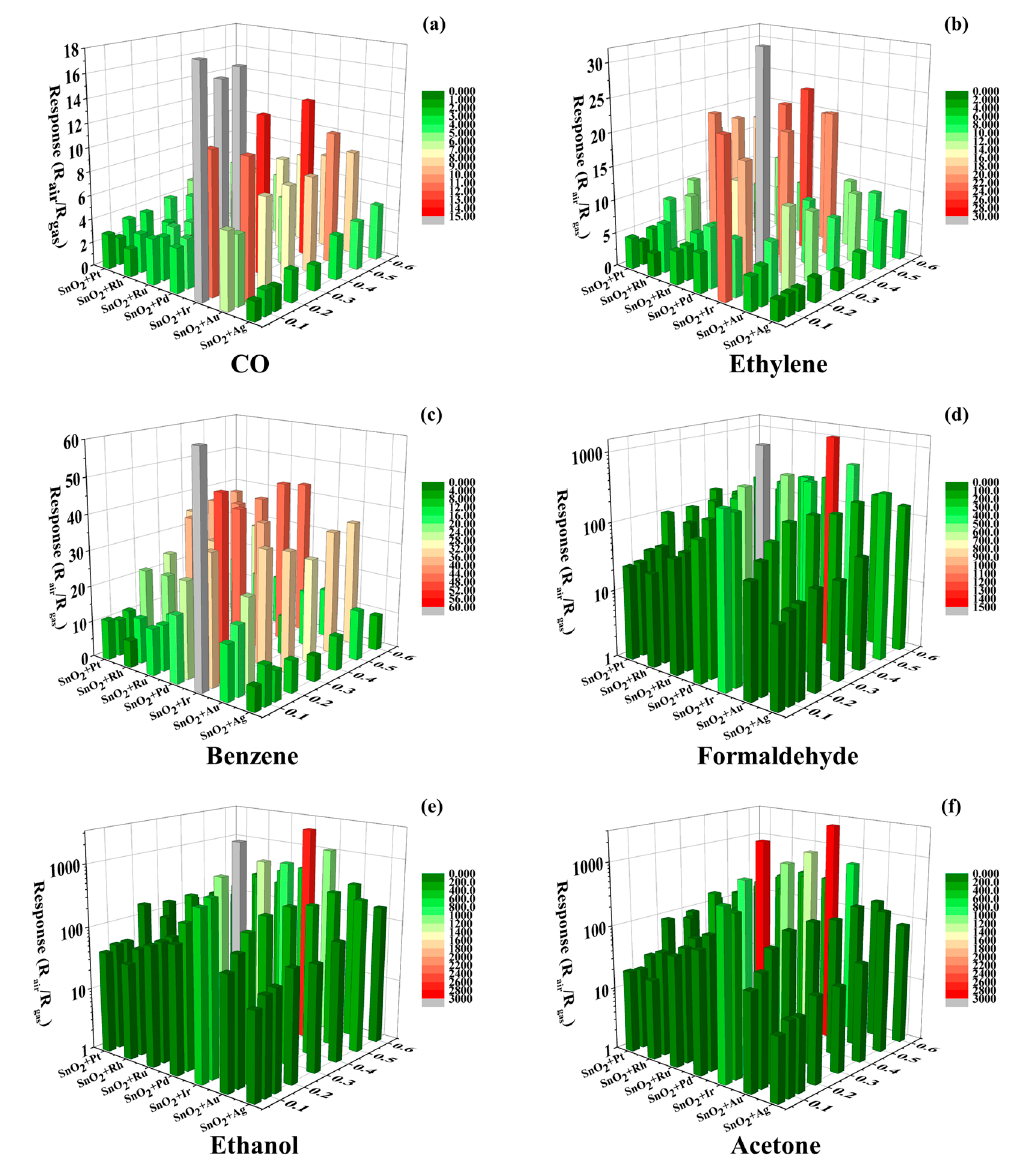
Figure 5. The high throughput resistance measurement (HT-RM) results of a sensor library based on nano-SnO 2 to 100 ppm of the six tested gases at 350 °C. ( a ) CO; ( b ) Ethylene; ( c ) Benzene; ( d ) Formaldehyde; ( e ) Ethanol; ( f ) Acetone.